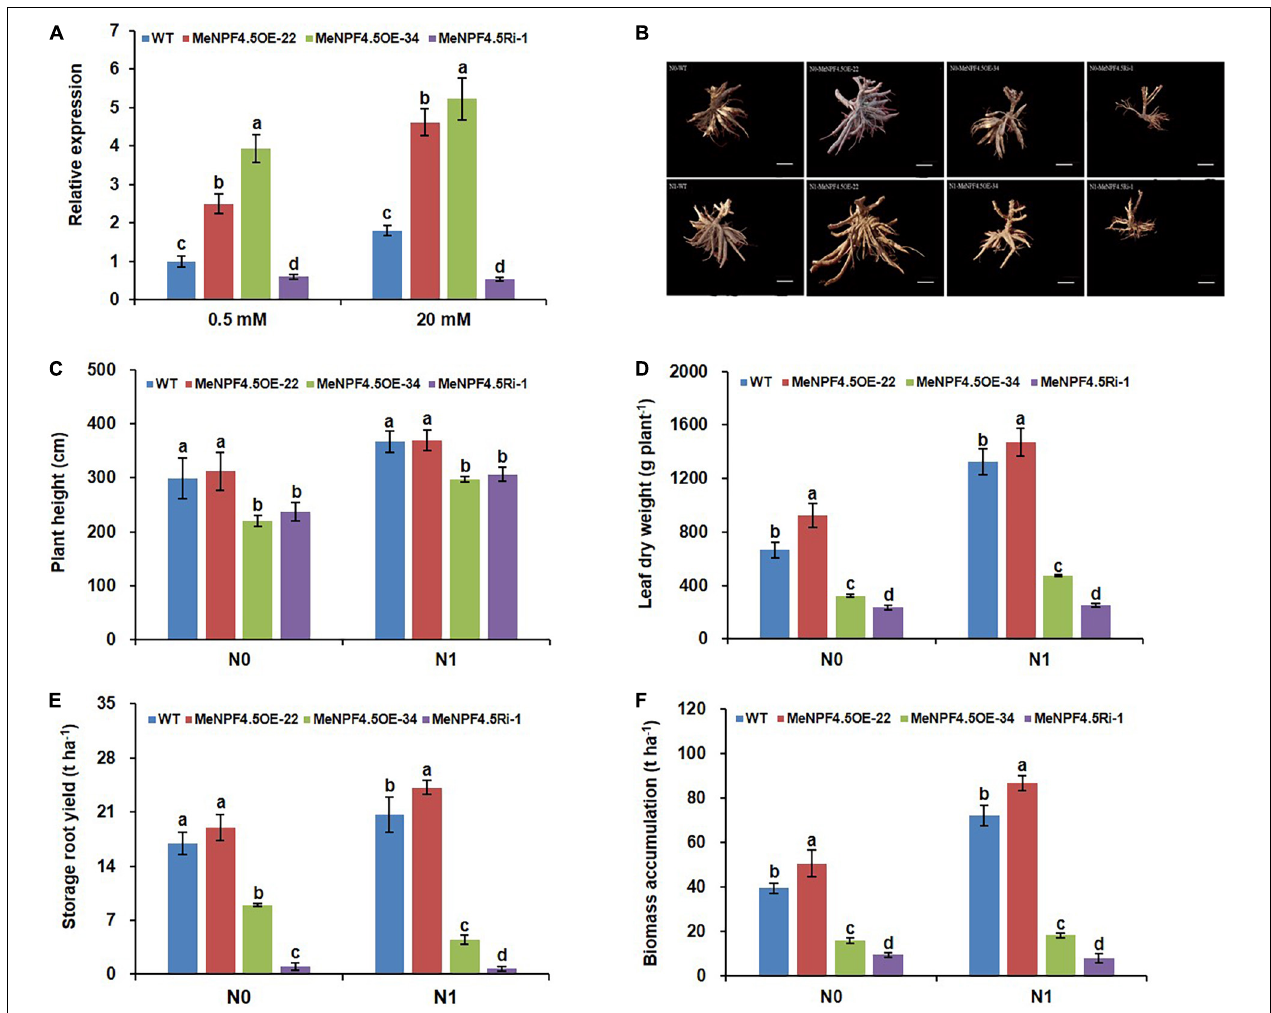
FIGURE 3 | Molecular identification and analysis of agronomic traits of WT and transgenic plants. (A) Real-time RT-PCR analysis of MeNPF4.5 gene expression in the roots of WT and transgenic plants under 0.5 and 20 mM NO 3 − . MeNPF4.5 OE, MeNPF4.5 overexpression; MeNPF4.5 Ri, MeNPF4.5 RNA interference. The Actin gene was used as an internal control. (B–F) Agronomic traits of WT and transgenic plants grown in the field for 8 months under different N0 (0 kg ha − 1 ) and N1 (125 kg ha − 1 ) conditions. (B) Storage roots of cassava plants grown in the field. N0 treatment (upper panel), N1 treatment (lower panel); from left to right, WT, MeNPF4.5 OE-22, MeNPF4.5 OE-34, and MeNPF4.5 Ri-1 images are shown. Bars = 10 cm. (C) Plant height ( n = 10). (D) Leaf dry weight ( n = 5). (E) Storage root yield ( n = 5). (F) Biomass accumulation ( n = 5). Values are means ± SE. Lowercase letters above the bars (a–d) represent significant differences between